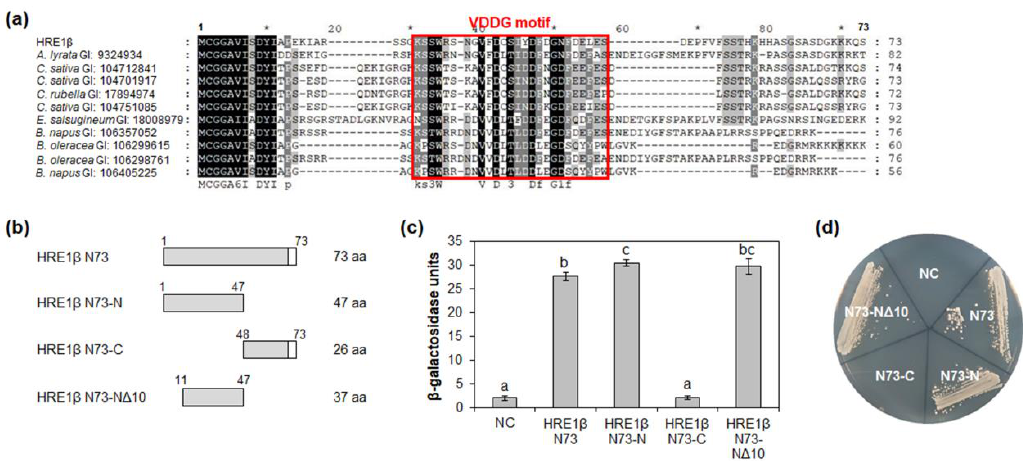
Figure 4. Analysis of transactivation activity of N-terminal region of HRE1 β . ( a ) Multiple sequence alignment was carried out with the amino acid sequences of HRE1 β N73 and corresponding regions of its orthologs using Clustal Omega. The GI number of each protein sequence is as follows: Arabidopsis lyrata : 9324934; Camelina sativa : 104712841, 104701917, 104751085; Capsella rubella :